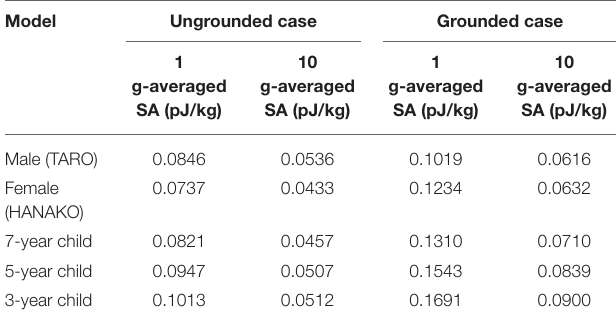
TABLE 5 | Maximum specific energy absorption normalized by an ICNIRP-prescribed power density limit of 2 W/m 2 for general exposures to various human model.